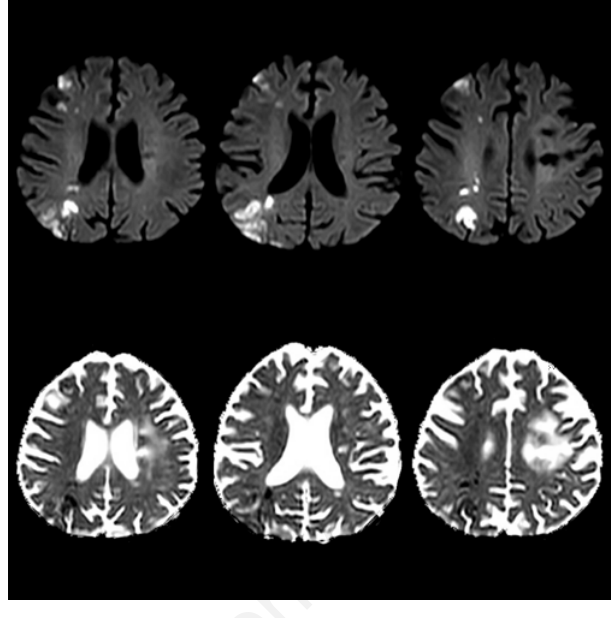
Figure 2. Axial view of brain magnetic resonance imaging, diffu- sion-weighted and apparent diffusion coefficient sequence: watershed acute ischemic infarction between apparent diffusion coefficient – multiple correspondence analysis and multiple cor- respondence analysis – principal component analysis territories in right side; hypersignality in diffusion-weighted and hyposig- nality in apparent diffusion coefficient is revealing water restric- tion in acute ischemia. The hypersignal area in apparent diffu- sion coefficient sequence in left hemisphere is related to an old